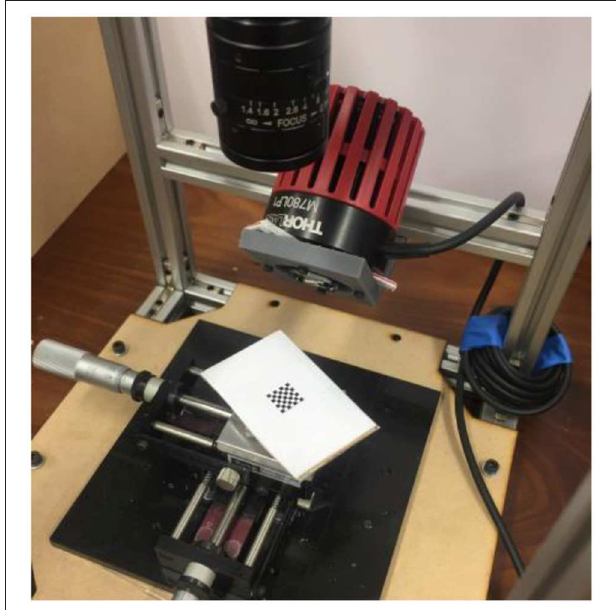
FIGURE 4 | Example of the set up used for calibrating the camera stereo parameters. The calibration squares were used in a number of orientations and